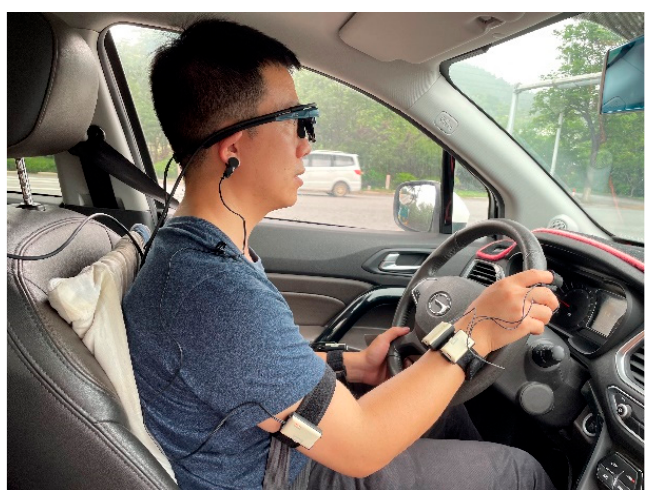
Figure 3. Vehicle driving experiment environment.